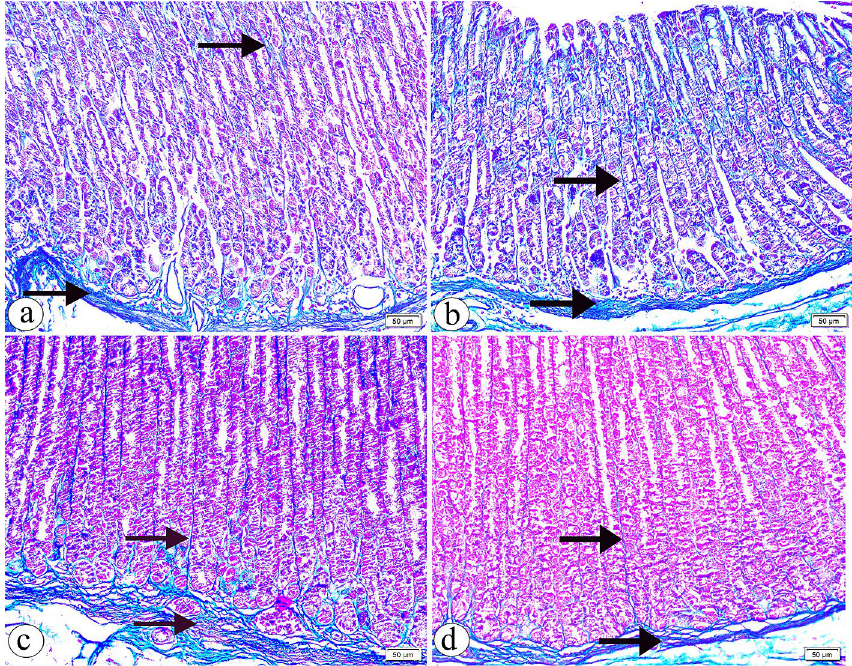
showing a normal distribution of the collagen fibres among the bases of the gastric glands, in the lamina propria and interstitial between the glands (arrow). ( b ) the group ӀӀ showing the collagen fibres distribution (arrow) more or less than the group Ӏ . ( c ) the group ӀӀӀ showing an increased collagen fibres deposition (arrow). ( d ) the group Ӏ V showing a minimal interstitial collagen fibres deposition (arrow). (Masson’s Trichrome, × 200, scale bar = 50